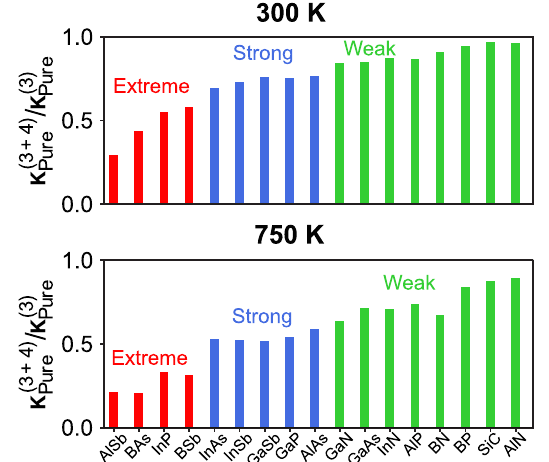
FIG. 1. Ratios of the thermal conductivities including four- phonon scattering to those omitting it ð κ blende compounds at 300 (top) and 750 K (bottom). The large thermal conductivity reductions even at 300 K show that the lowest-order theory of phonon-phonon interactions is failing for many of these